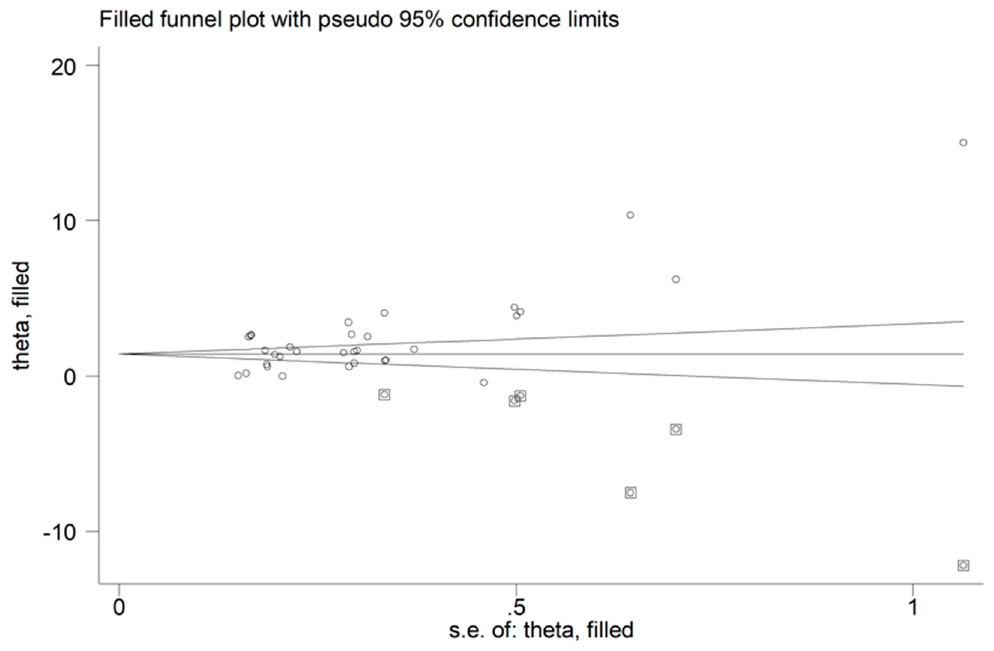
Figure 5. Funnel plot of ischaemia-modified albumin concentrations in patients with acute coronary syndrome and controls after “trimming-and-filling”. Dummy studies and genuine studies are represented by enclosed circles and free circles, respectively.